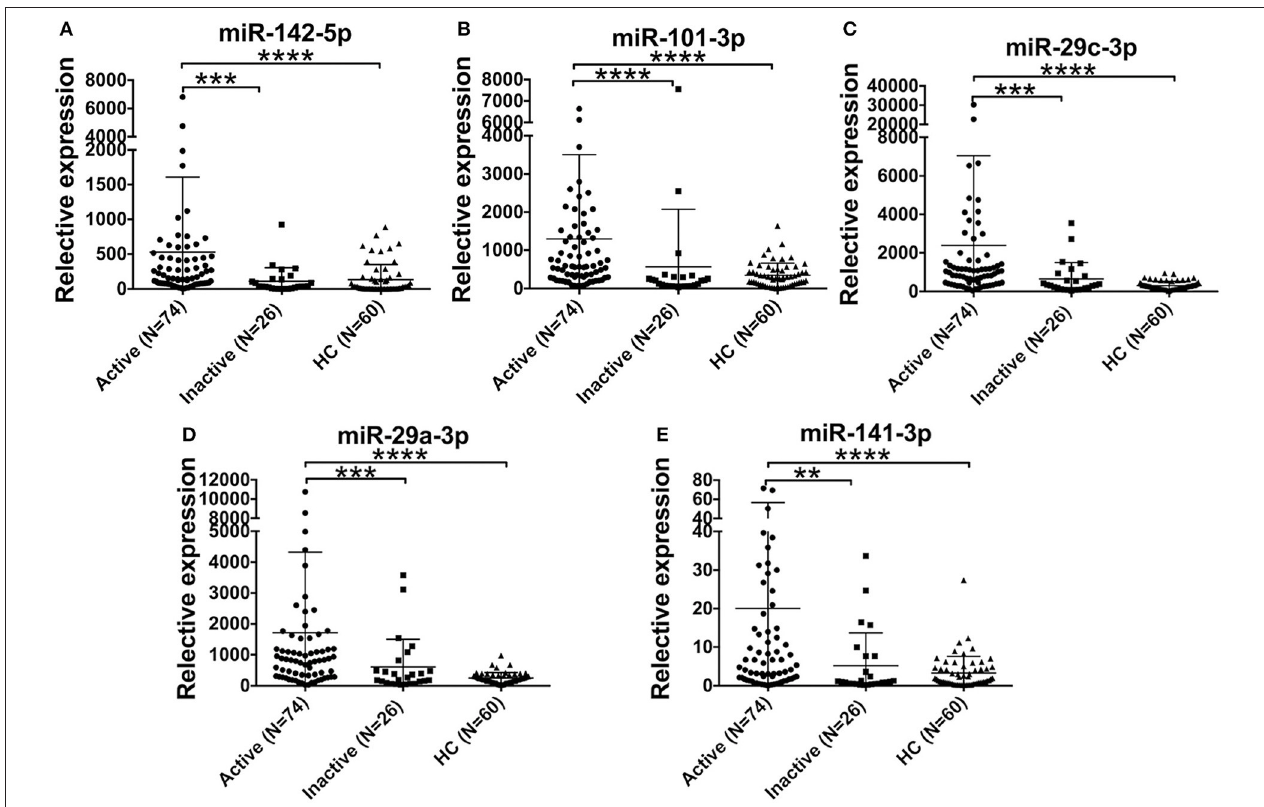
FIGURE 4 | Association of the miRNA signature with AOSD disease activity. Expression levels of (A) miR-142-5p, (B) miR-101-3p, (C) miR-29c-3p, (D) miR-29a-3p, (E) miR-141-3p in active AOSD ( N = 74) and inactive AOSD ( N = 26) patients, and plasma samples from 60 HCs were used as control. The results of histograms represent the means ± SD, ** P < 0.01, *** P < 0.001, **** P < 0.0001.